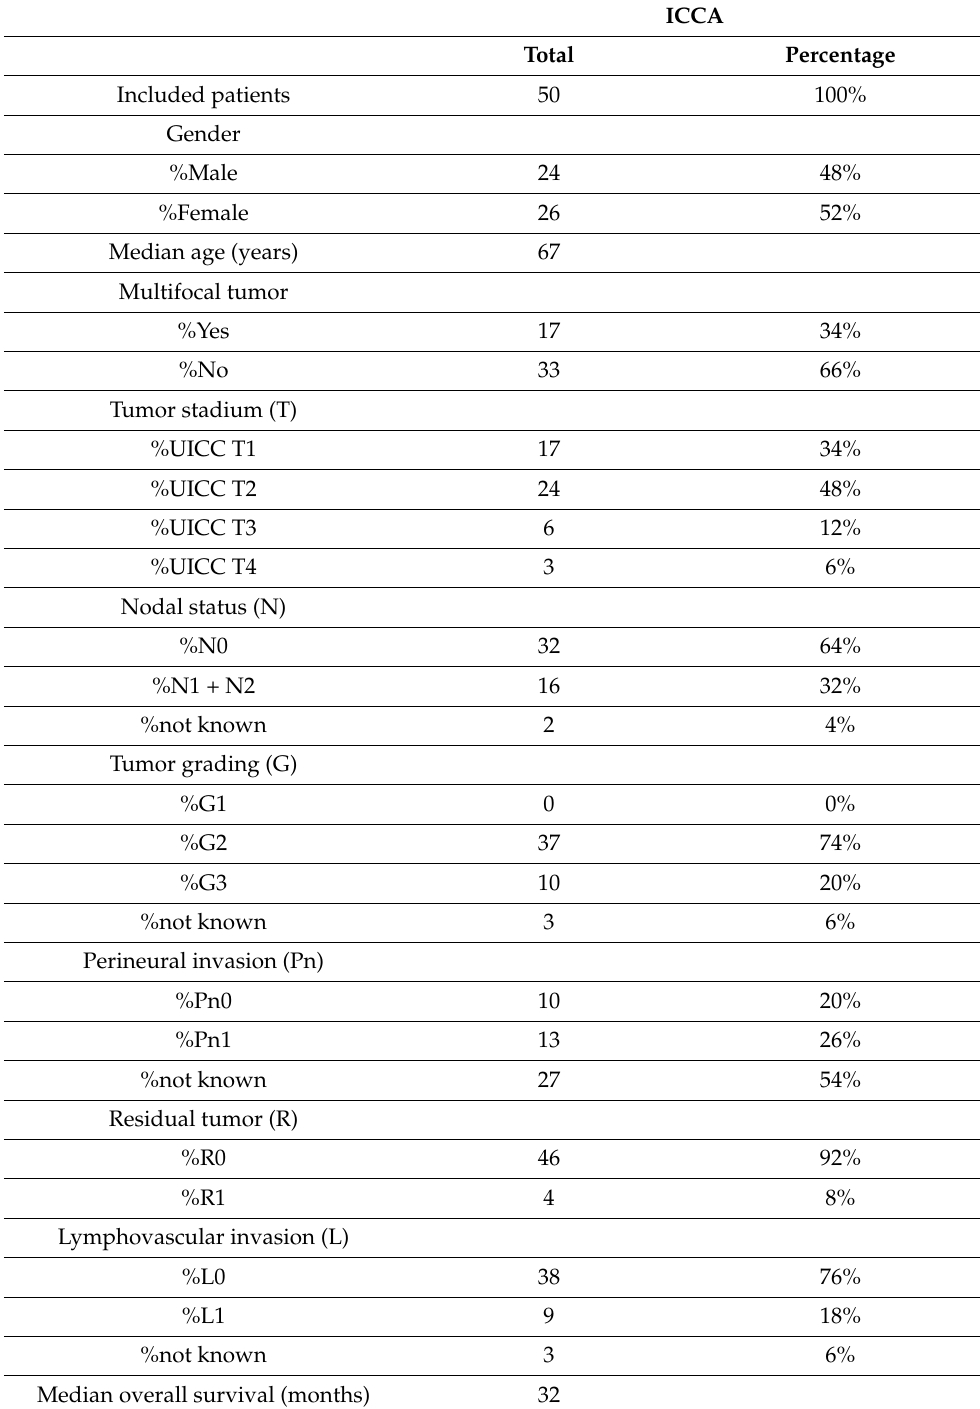
Table 1. Patient